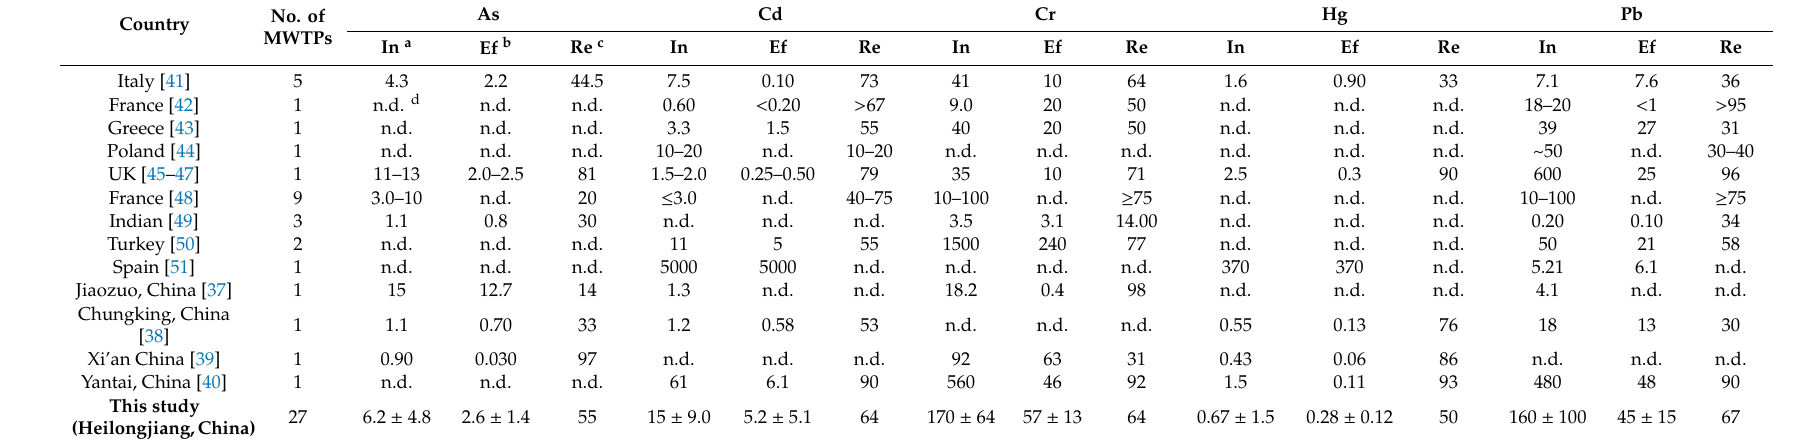
Table 2. Comparison of influents and e ffl uents concentrations ( µ g / L) and removal ratios (%) of five heavy metals in di ff erent countries.